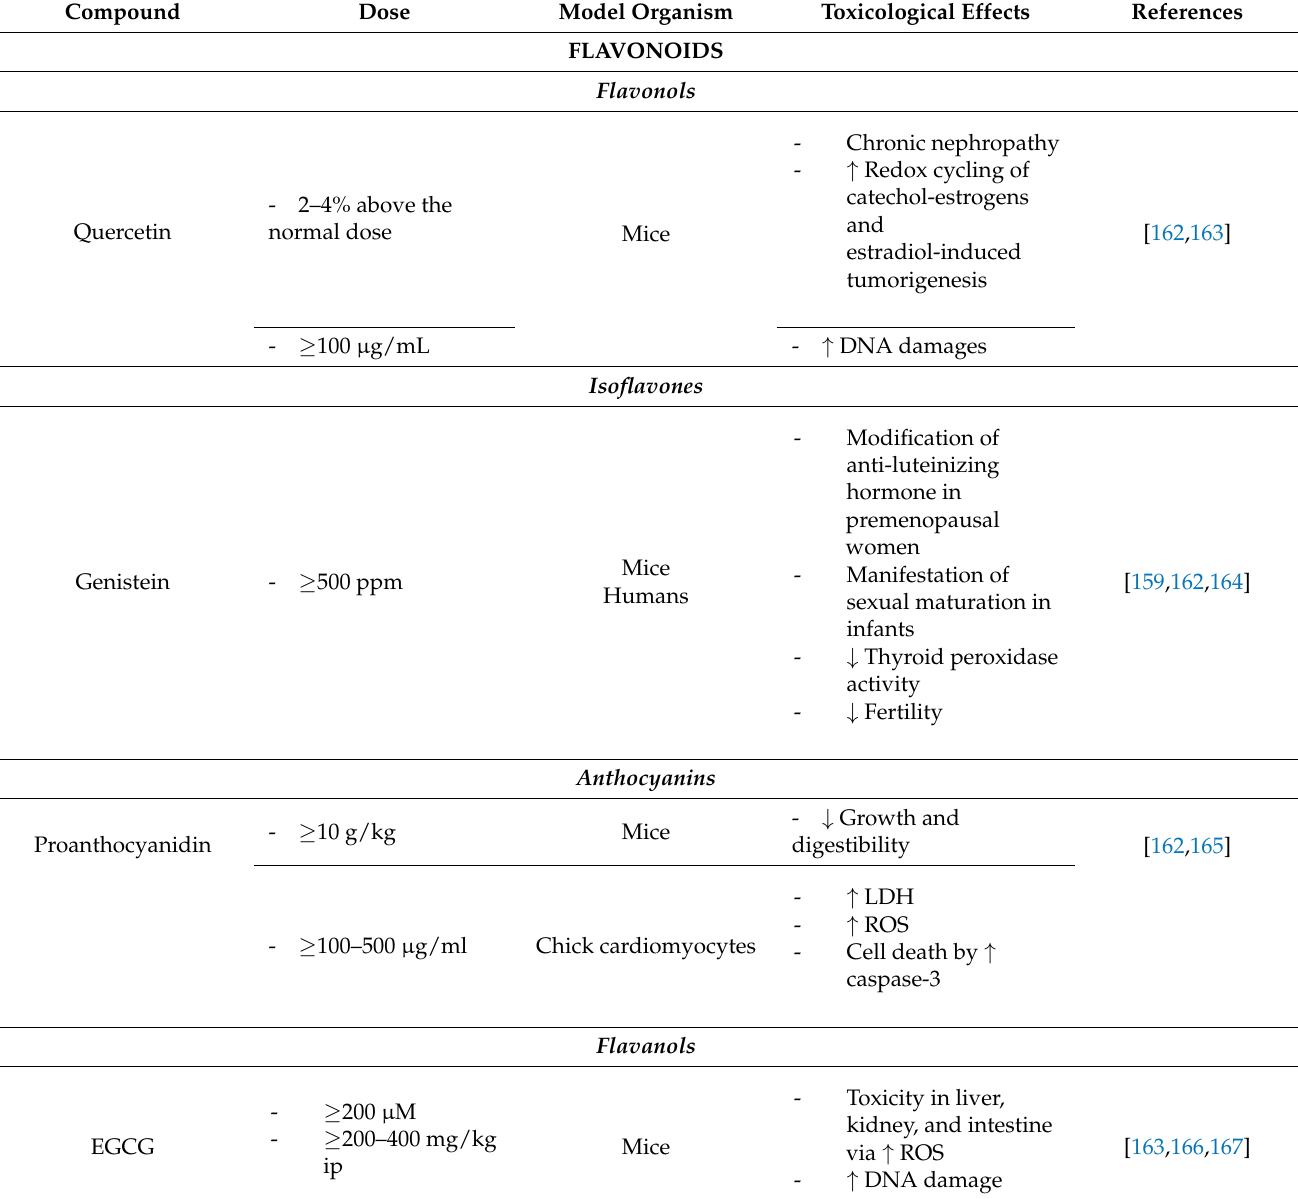
Table 2. Polyphenols’ main toxic effects based on their high administration